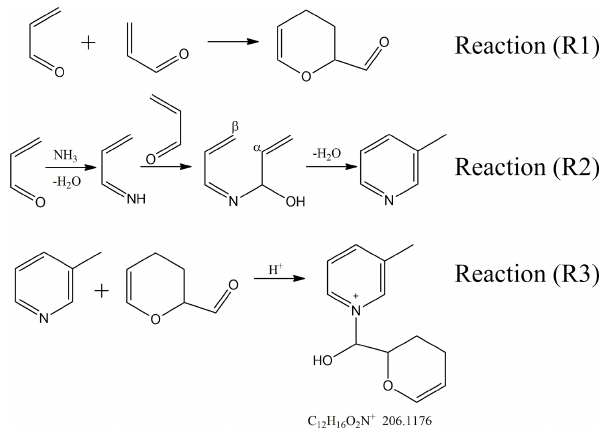
Figure 2. Proposed reactions of acrolein with ammonia or ammo- nium ion that explain the products observed in this